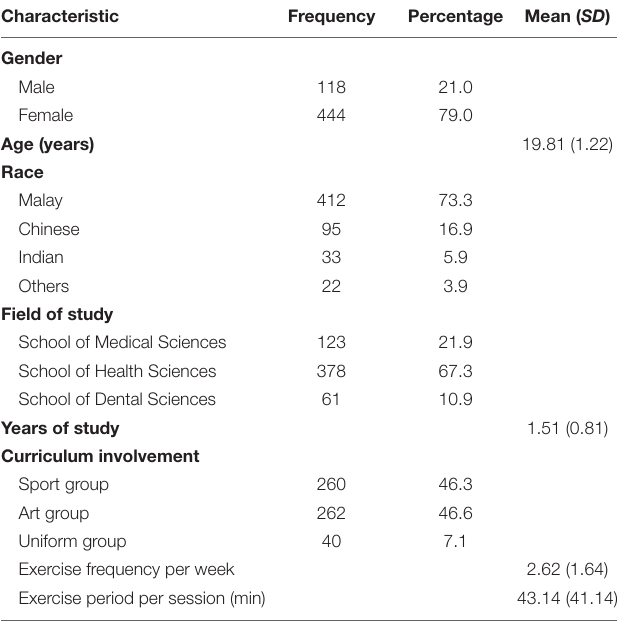
TABLE 1 | Demographic characteristic of undergraduate health and medical students.